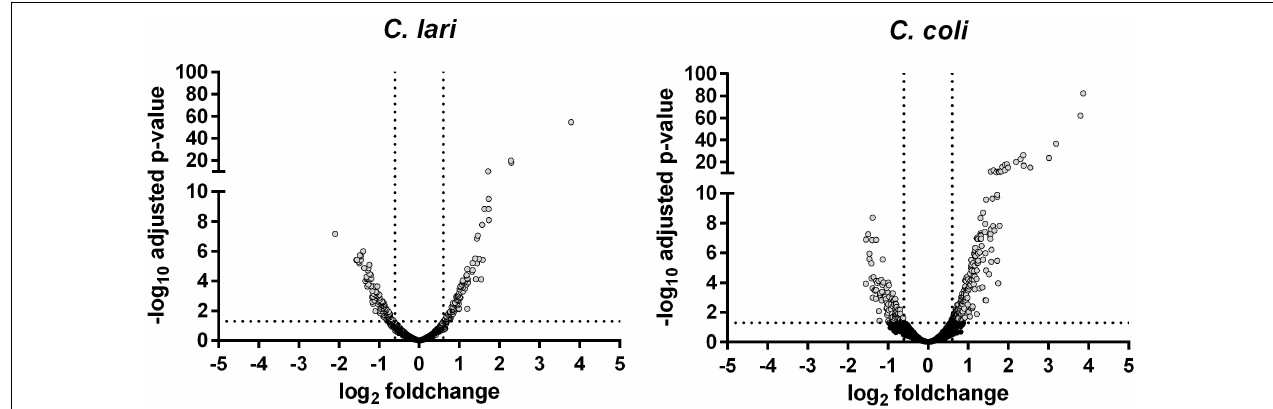
FIGURE 3 | Gene expression profile of the whole transcriptome of C. coli RM2228 and C. lari RM2100 after 30 min of heat stress. Whole transcriptome was analysis after 30 min incubation at 46 ◦ C by RNA sequencing and gene expression shown in volcano plots as log 2 fold change versus -log 10 p-values of biological duplicates. Gray: significantly different expressed